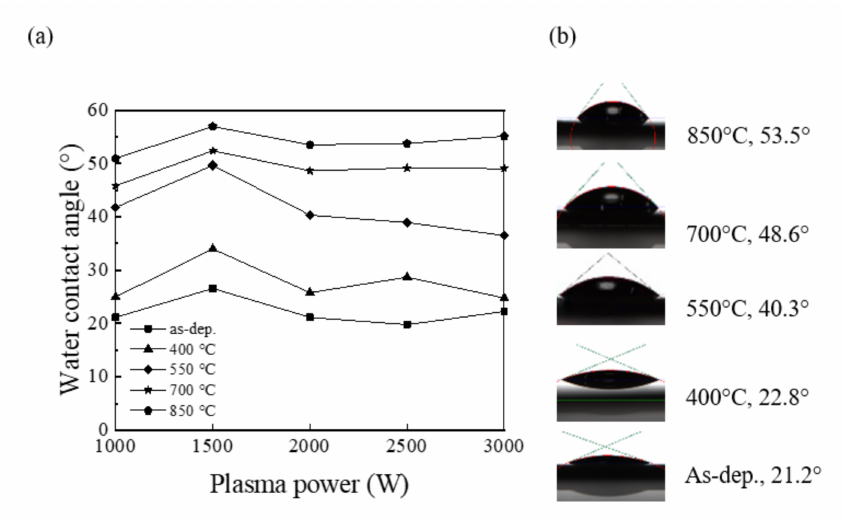
Figure 9. ( a ) WCA for the RP-ALD SiO 2 films with various plasma powers at different annealing temperatures; ( b ) WCA for the SiO 2 films when the plasma power is 2000 W at different annealing temperatures.